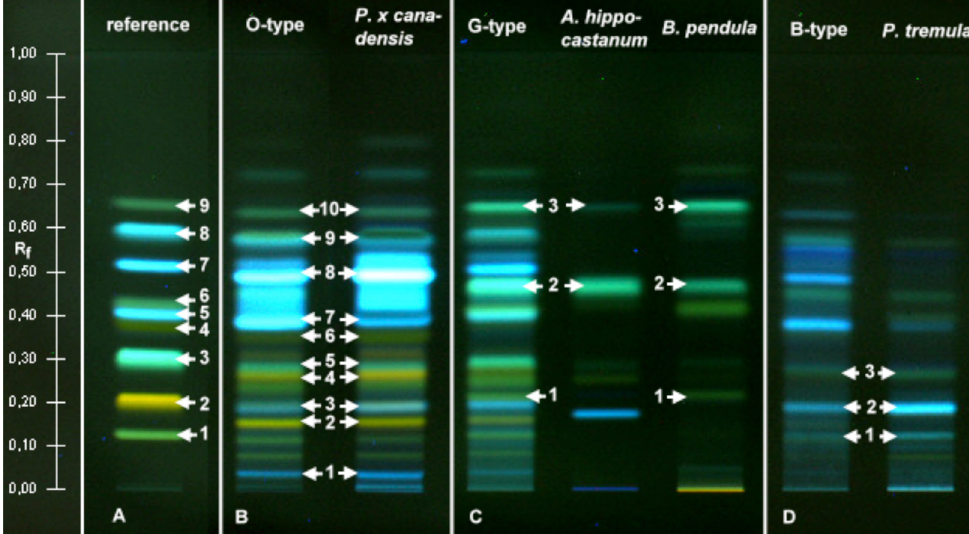
Fig. 5: Chromatographic separation specifying the bands investigated in TLC-MS experiments. (A) Reference mixture, (B) O-type propolis and P. x cana- densis bud extracts, (C) G-type propolis and A. hippocastanum L. and B. pendula Roth bud extracts, (D) B-type propolis and P. tremula L. bud ex- tract.